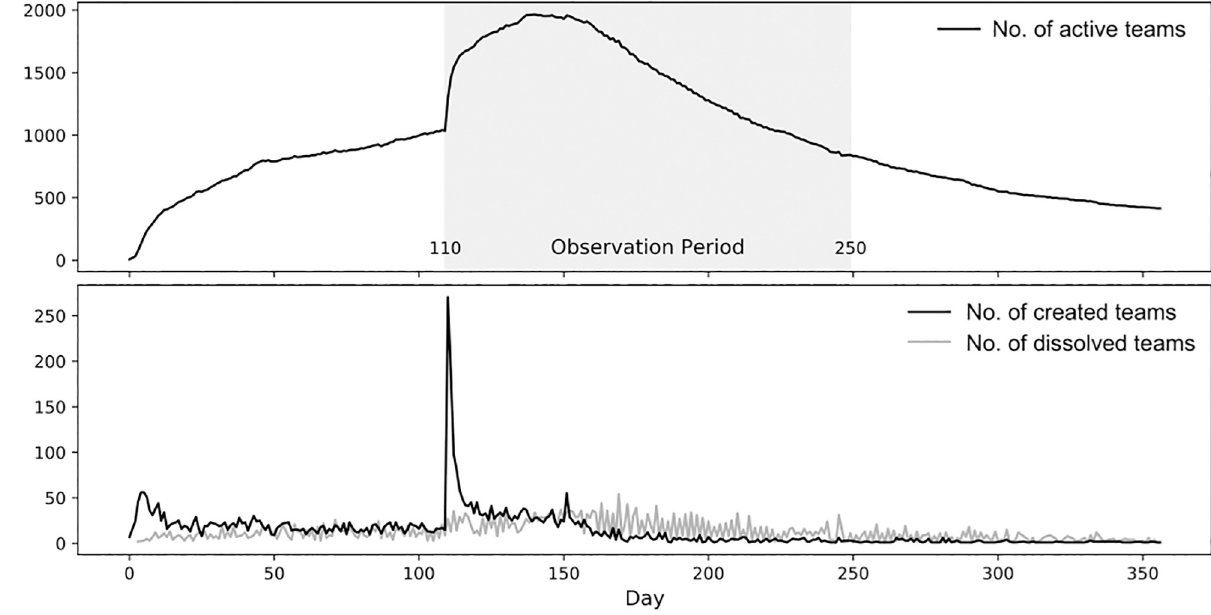
Fig 3. Teams within Travian constantly form and dissolve. In the first phase of the game, the number of alliance formations exceeds the number of dissolutions, which finds its peak at the beginning of the middle phase of the game. At this point a massive reorganization process takes place. In the later phases of the game, the number of team dissolutions exceeds the number of new formations, so the number of active teams steadily decreases.